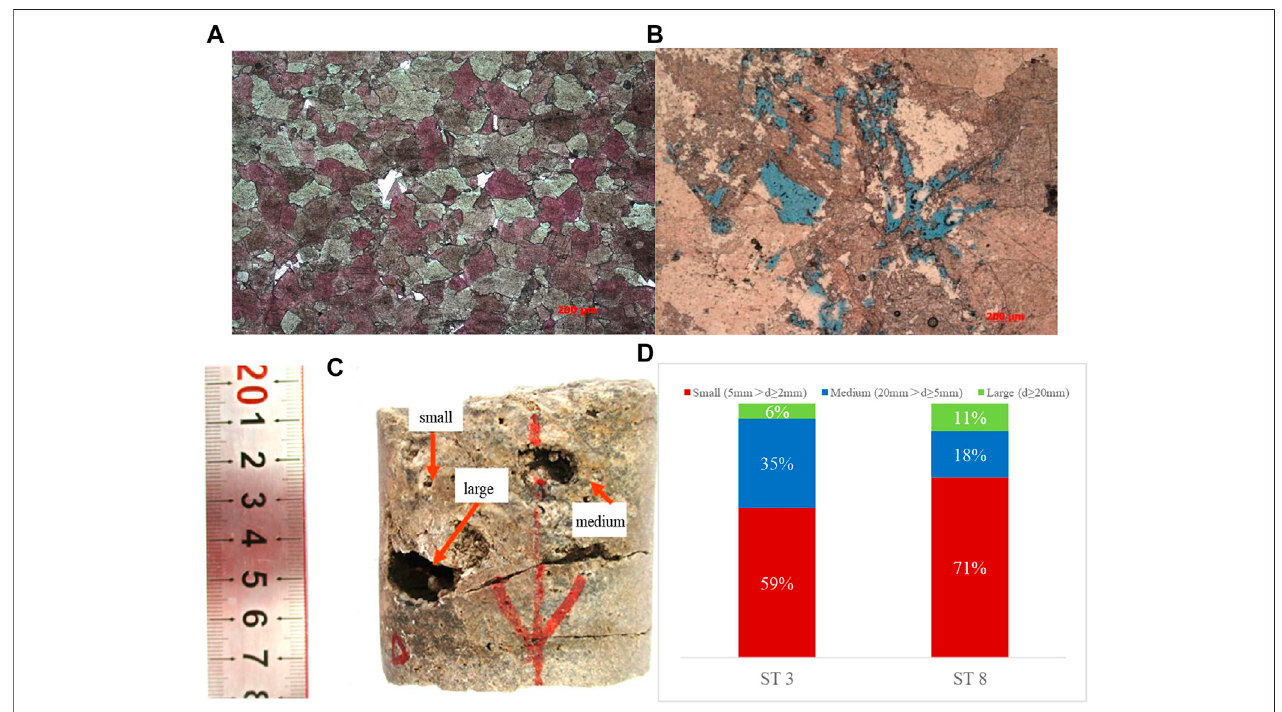
FIGURE 1 | Reservoir spaces of Qixia Fm limy dolomite. (A) ST8 downhole core, intergranular pores; (B) ST 3 downhole core, intergranular dissolved pores; (C) ST3 downhole core, medium-to-small karst caves; and (D) percentage of karst caves with different diameters.